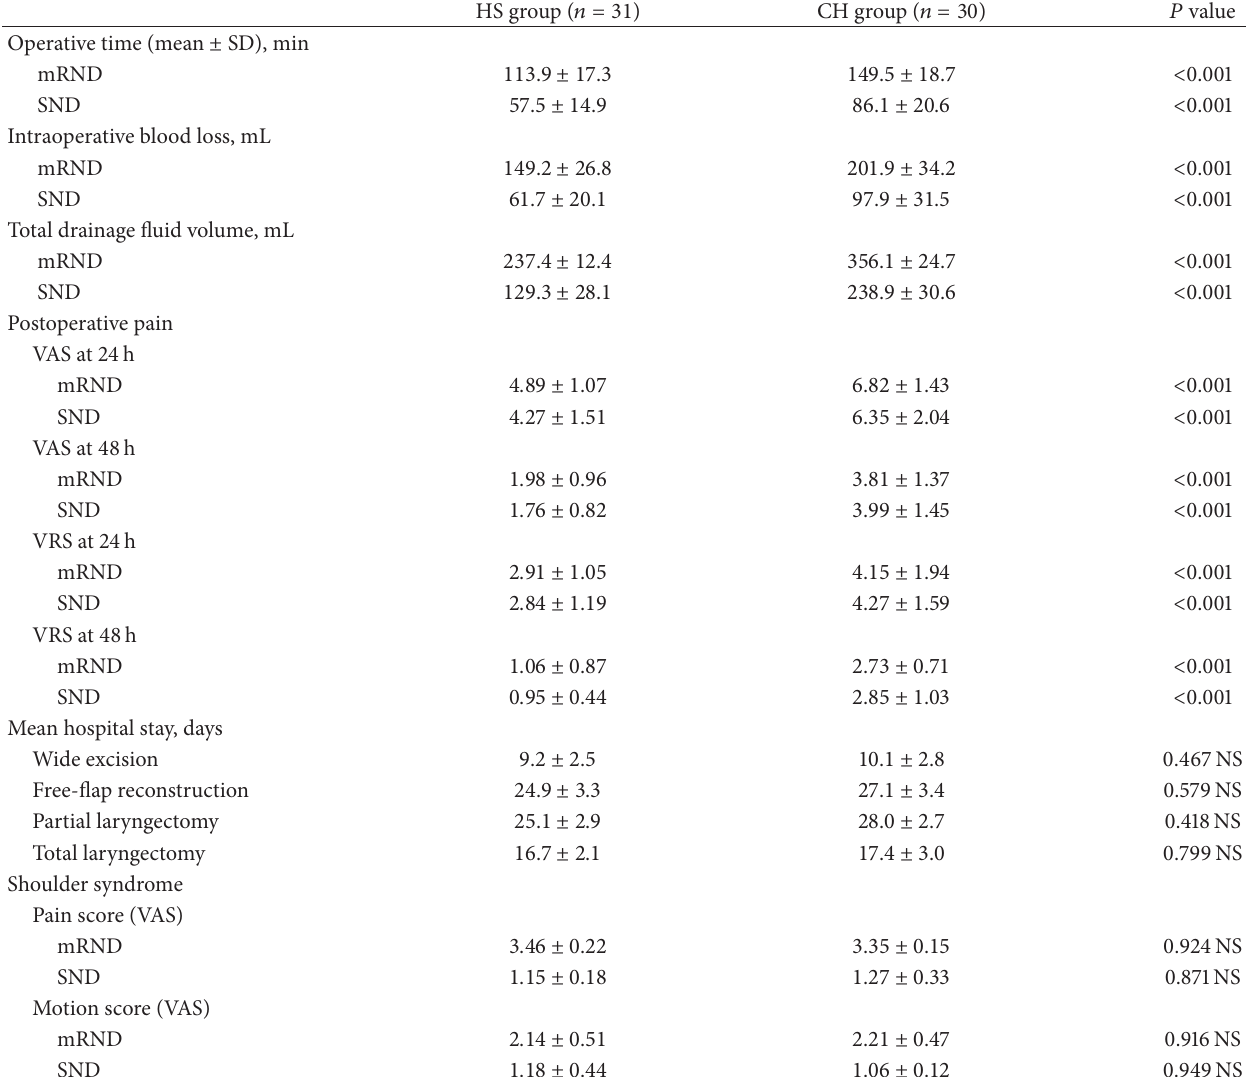
Table 2: Operative and postoperative data in harmonic scalpel (HS) and conventional hemostasis (CH)